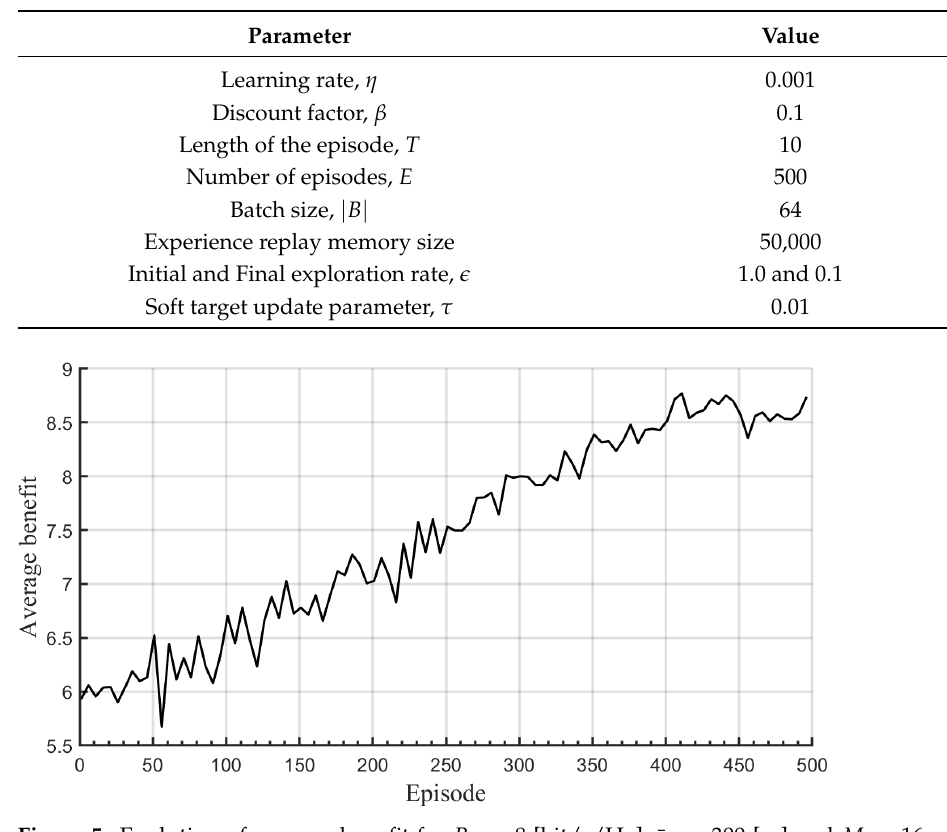
Figure 5. Evolution of average benefit for R c = 8 [bit/s/Hz], ¯ r c = 300 [m] and M = 16, where average values of benefit over every 5 episodes are